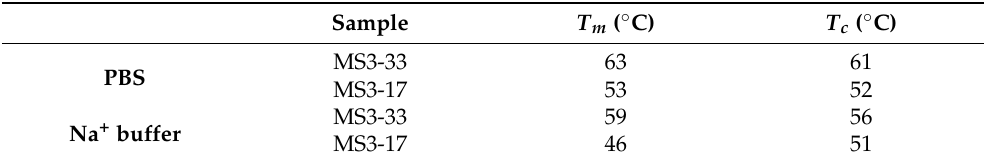
Table 1. Apparent melting temperature values obtained for the unfolding ( T m ) and refolding ( T c ) of MS3-33 and MS3-17 analogues by UV-monitored thermal experiments at 295 nm in the selected saline conditions. The error on T m and T c determination is ± 1.0 ◦ C.